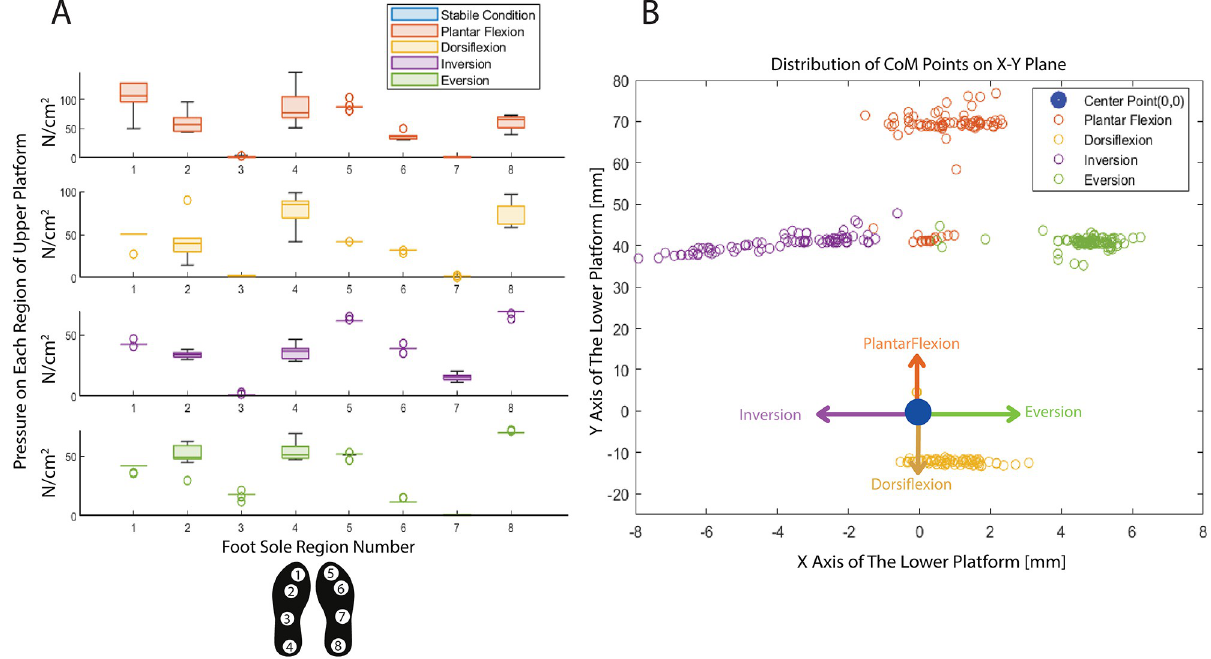
Fig 13. Experimental evaluation of the upper and lower platforms under dynamic condition (A) Pressure distribution of the payloads while the end- effector is in anthropomorphic motion (B) Variation of CoM of payloads while the end-effector is in anthropomorphic motion.